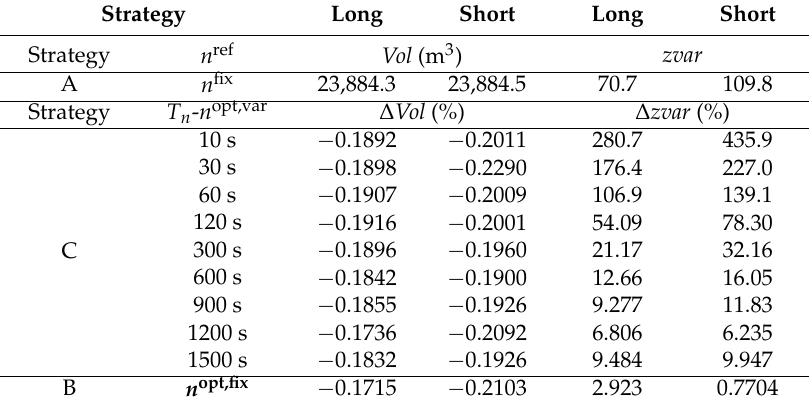
Table 6. Vol and zvar with the three control strategies and different update periods for the strategy C, n fix = 1.0882 p.u.